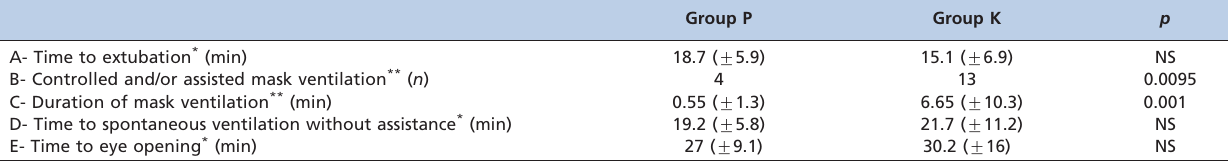
Table 4 - Emergence characteristics.